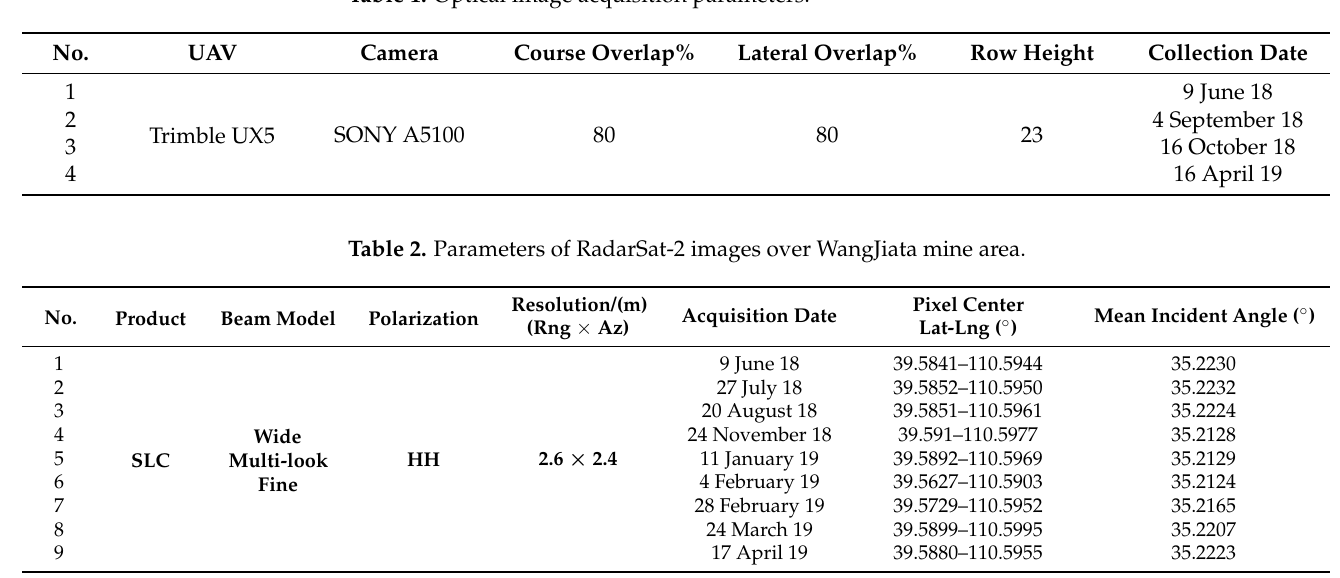
Table 1. Optical image acquisition parameters.